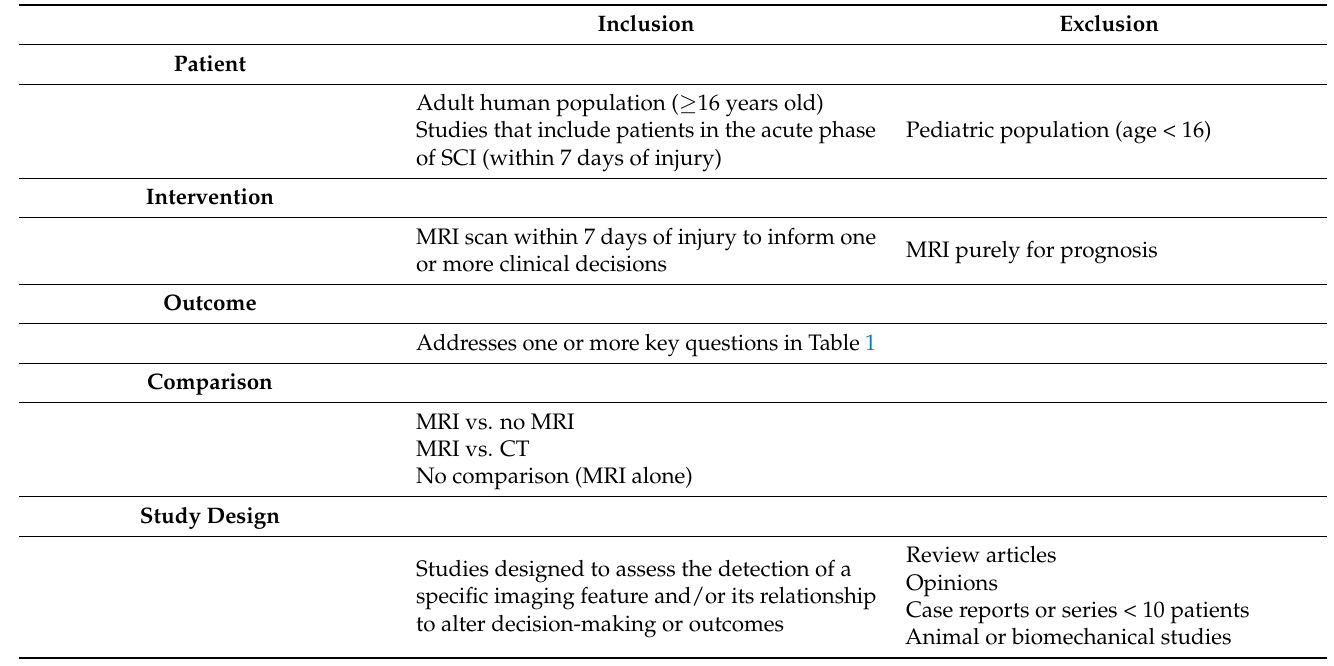
Table 2. PICO Summary of Inclusion and Exclusion